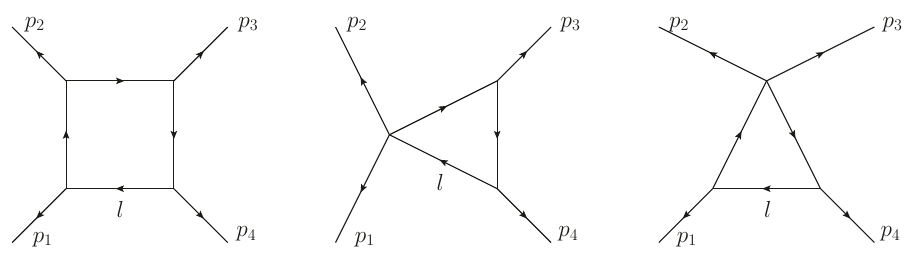
. Center: the s -channel scalar I box ( s ) ( t ) . Right: the t -channel scalar triangle integral, . triangle triangle I I ( s ) , the s -channel triangle , and the box triangle I I ( t ) , shown in (cid:12)gure 1. triangle I